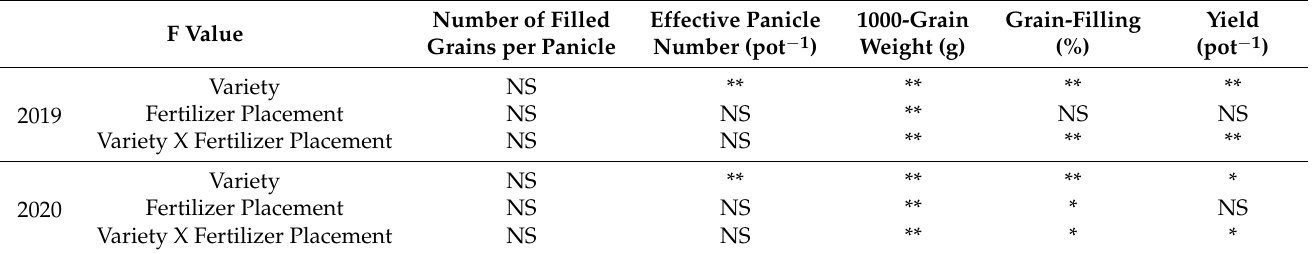
Table 3. The interactions between variety and fertilizer placement on yield and its